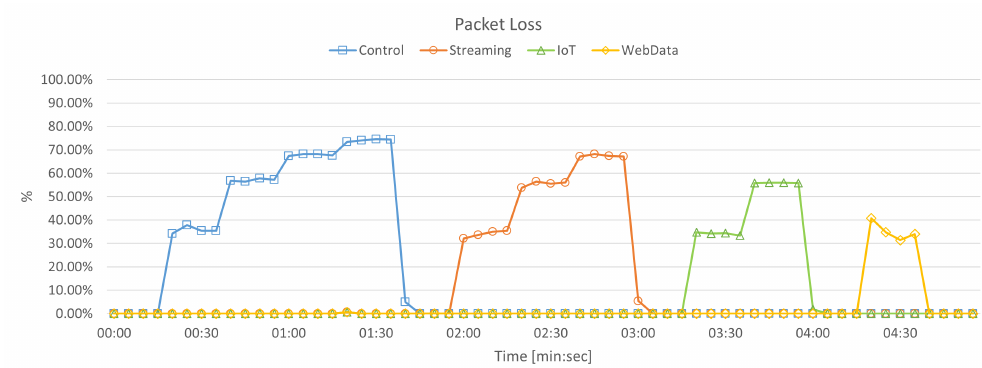
Figure 9. Packet loss obtained from the scenario without prioritization.